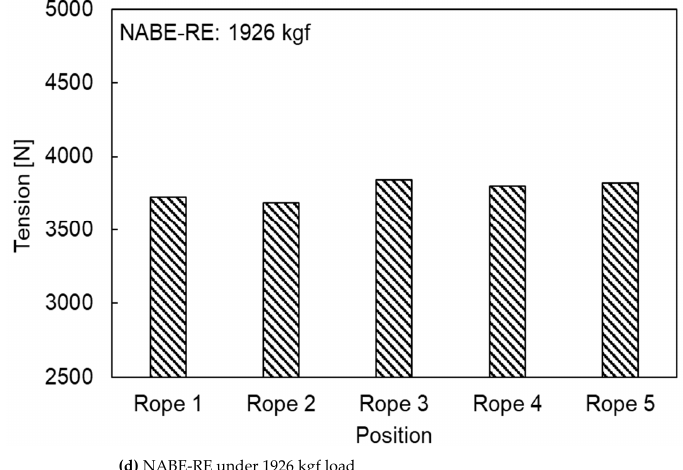
Figure 14. Experimental results of the tension performance test.